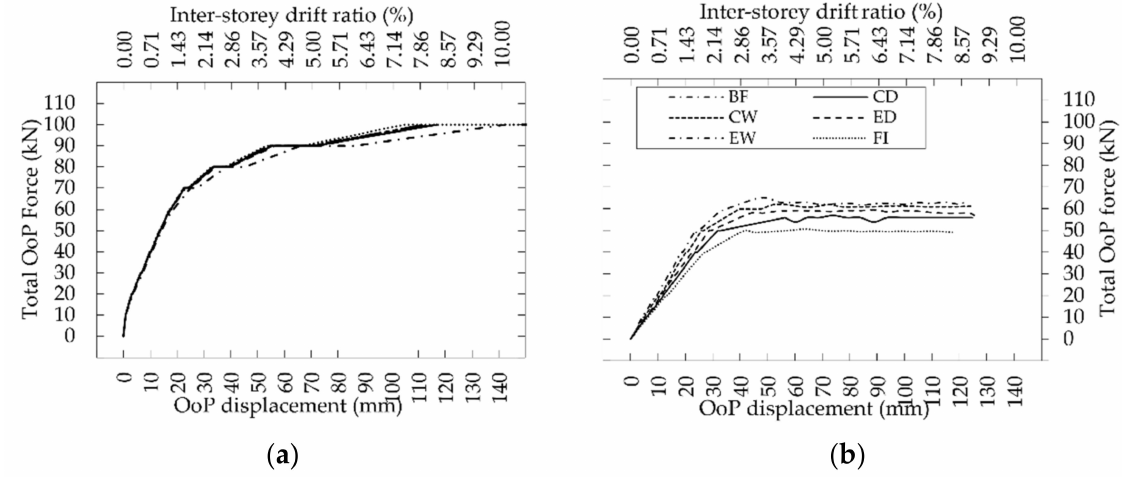
Figure 24. Load-capacity curves from OoP cyclic, quasi-static tests. ( a ) Computational model; ( b ) experimental